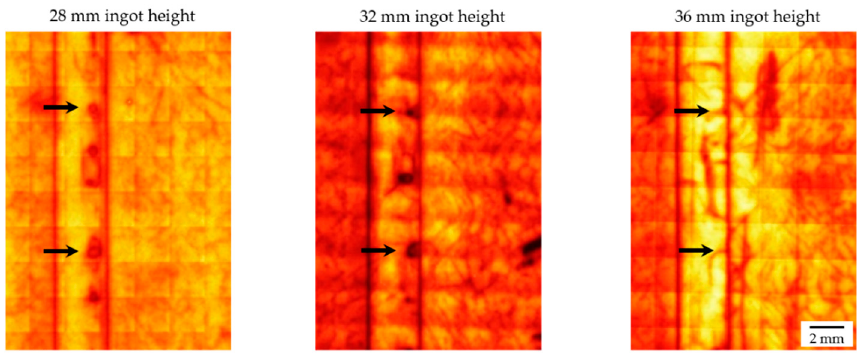
Figure 5. µPL map of dislocation loops between functional grain